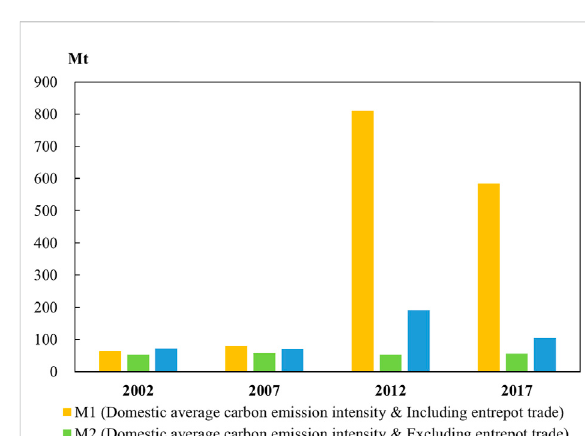
FIGURE 11 Comparison of CBE results of three calculation methods in 2002 –